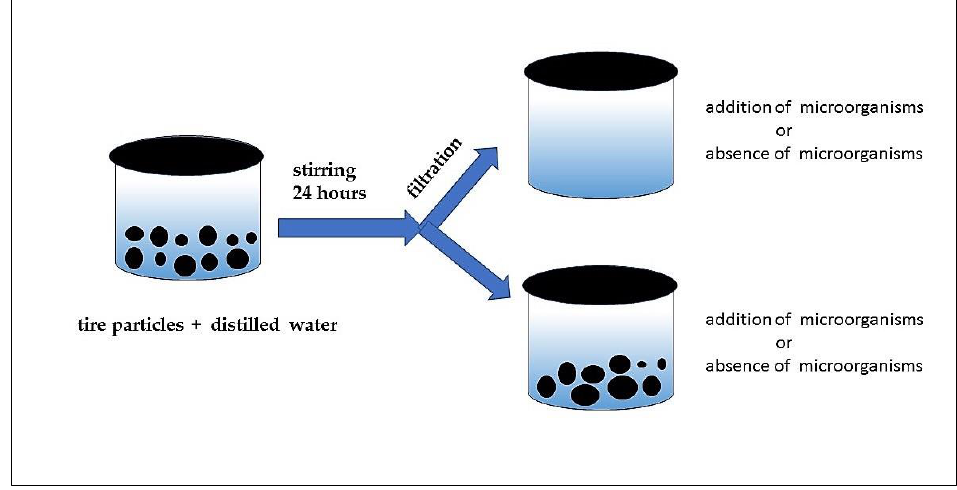
Figure 1. Scheme of experimental designs (respiration test)—preparation of